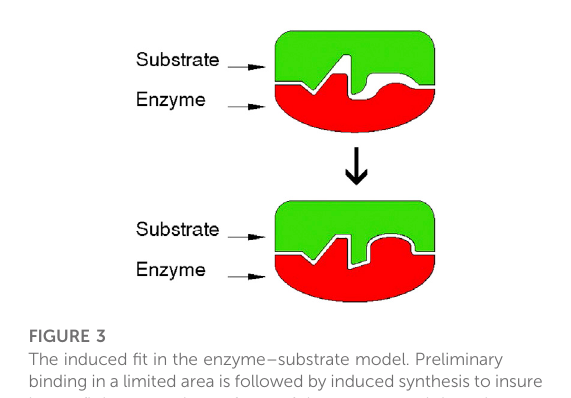
FIGURE 3 The induced fi t in the enzyme – substrate model. Preliminary binding in a limited area is followed by induced synthesis to insure better fi t between the surfaces of the enzyme and the substrate, also generating micro interlocking. Adapted from Ciferri 2021. Designer: Luca Galbusera,